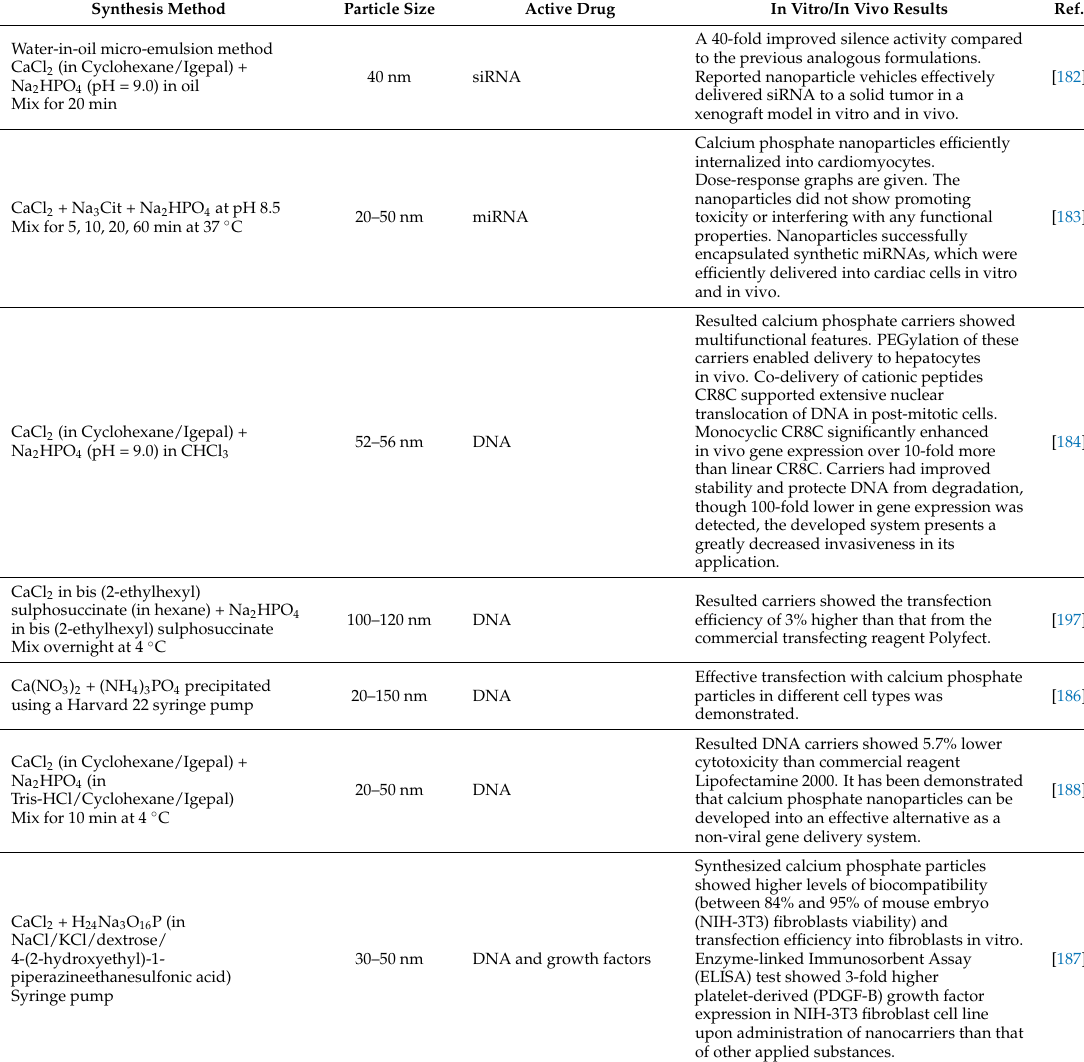
Table 3. Recently studied calcium phosphate drug delivery systems. Synthesis